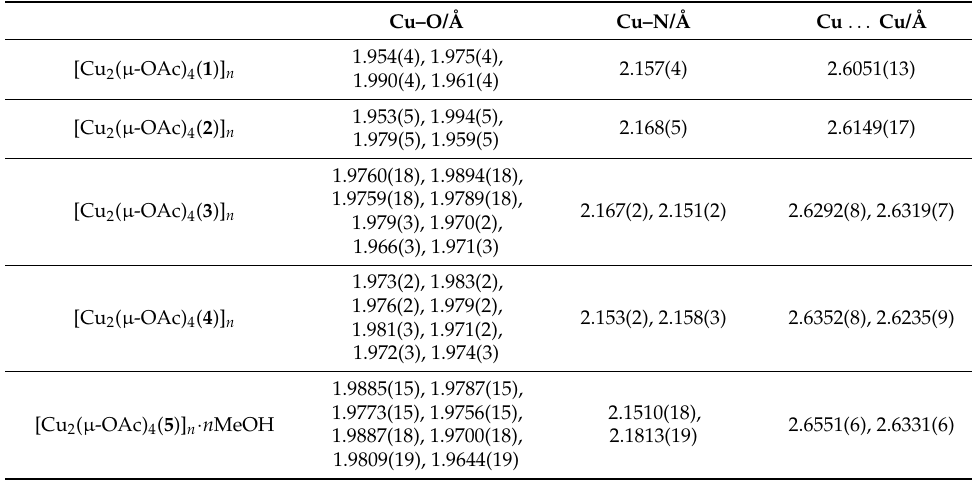
Figure 4. The repeat units (with symmetry generated atoms) in ( a ) [Cu 2 ( µ -OAc) 4 ( 3 )] n (symmetry codes: i = 1 − x , 2 − y , 2 − z ; ii = 2 − x , 2 − y , 1 − z ), ( b ) [Cu 2 ( µ -OAc) 4 ( 4 )] n (symmetry codes: i = 2 − x , 2 − y , 1 − z ; ii = 1 − x , 2 − y , 2 − z ), and ( c ) [Cu 2 ( µ -OAc) 4 ( 5 )] n · n MeOH (solvent molecule omitted; symmetry codes: i = 1 − x , 2 − y , 2 − z ; ii = 2 − x , 2 − y , 1 − z ), All ellipsoids are plotted at 40% probability level, and H atoms are omitted for clarity. Table 1. Selected bond lengths in the copper(II) coordination